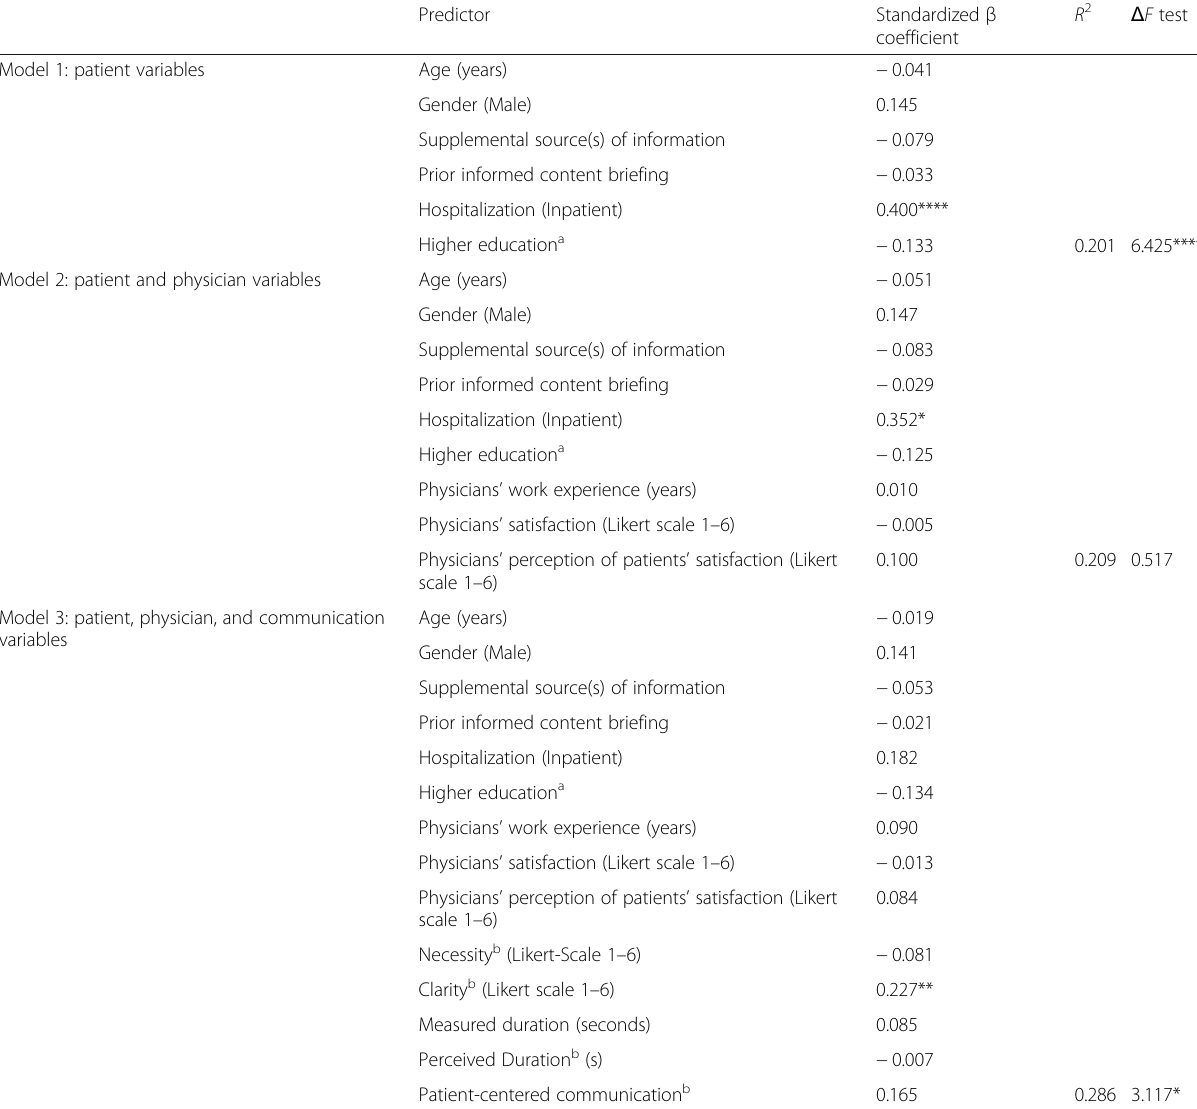
Table 3 Hierarchical regressions for the prediction of patients ’ satisfaction Predictor Standardized β